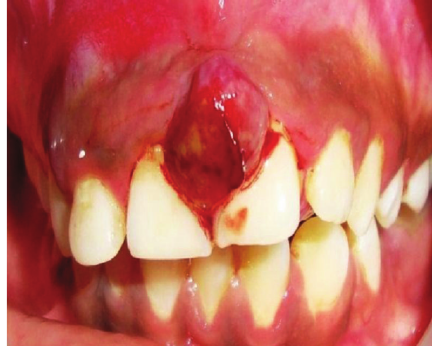
Figure 8: Intraoral view showing unilateral